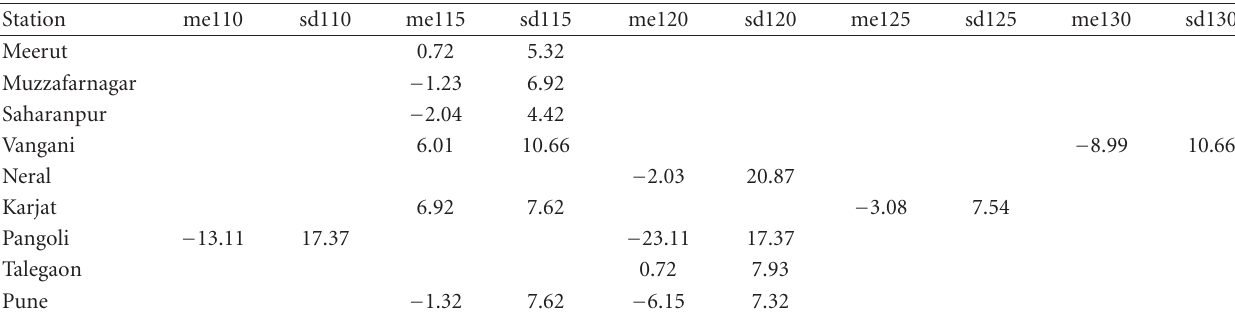
Table 4: Standard deviations and mean errors of the predictions of radio planning tool